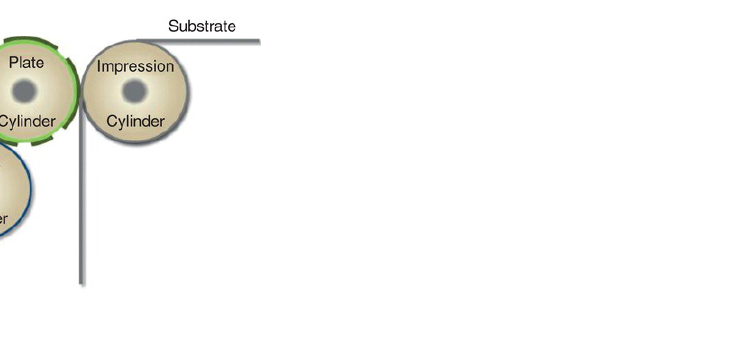
Figure 6. Flexographic printing process of the mucoadhesive film (Reprinted with permission from Kolakovic et al. 2013 [72]).